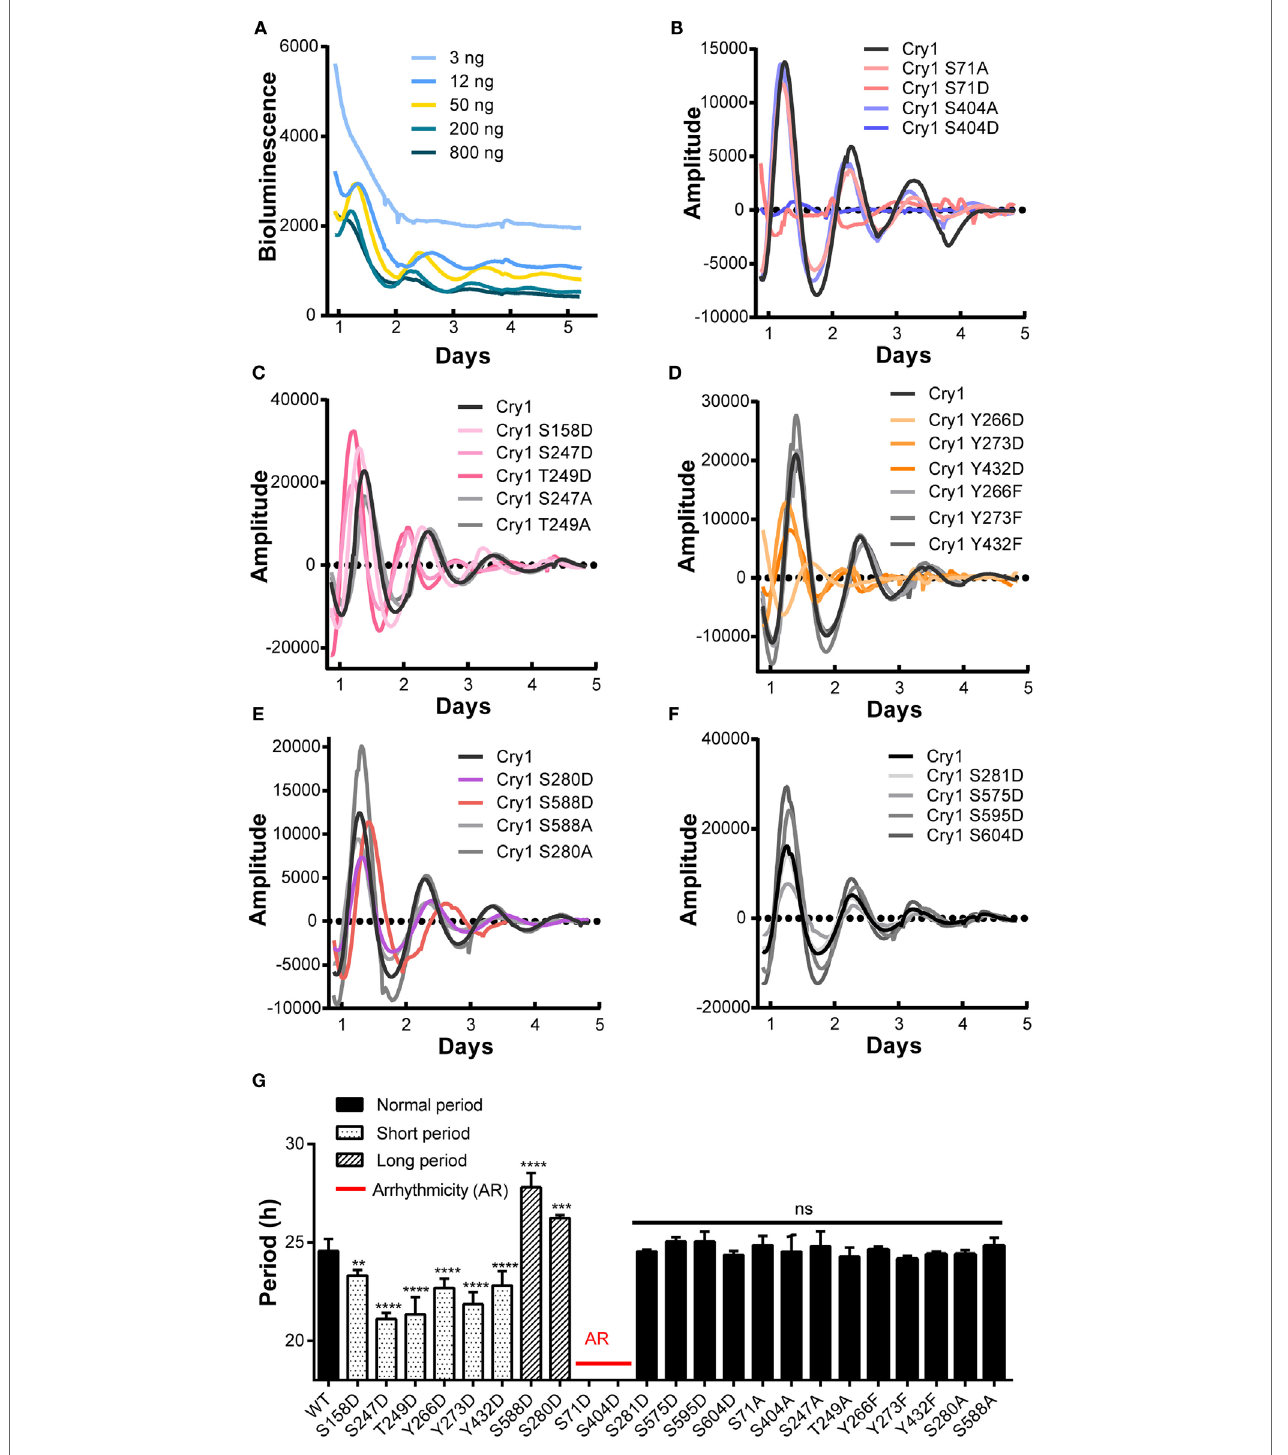
FigUre 1 | a cell-based screen to identify critical phosphorylation residues on mcrY1 through rescuing rhythmicity in Cry1 − / − :Cry2 − / − fibroblasts (DKO cells) . (a) Dosage-dependent rescue of circadian rhythms in DKO cells by mCRY1. The mCRY1 expression vector was cotransfected into cells with the P( Per2 )-dLuc reporter vector. Three days after transfection, the cells were synchronized by dexamethasone treatment and then moved to luciferin-containing medium for 5–6 days of bioluminescence recording. (B–F) The P( Per2 )-dLuc reporter rhythms (baseline subtracted) from DKO cells transfected with WT or mutant mCRY1, as noted in the legend. Experiments were performed as in (a) . (g) Quantitation of the period length from WT and mutant mCRY1 transfected cells that showed a distinct period phenotype as noted in the legend. Error bars represent SEM ( n ≥ 5, ** p < 0.01; *** p < 0.001; **** p < 0.0001, ANOVA).